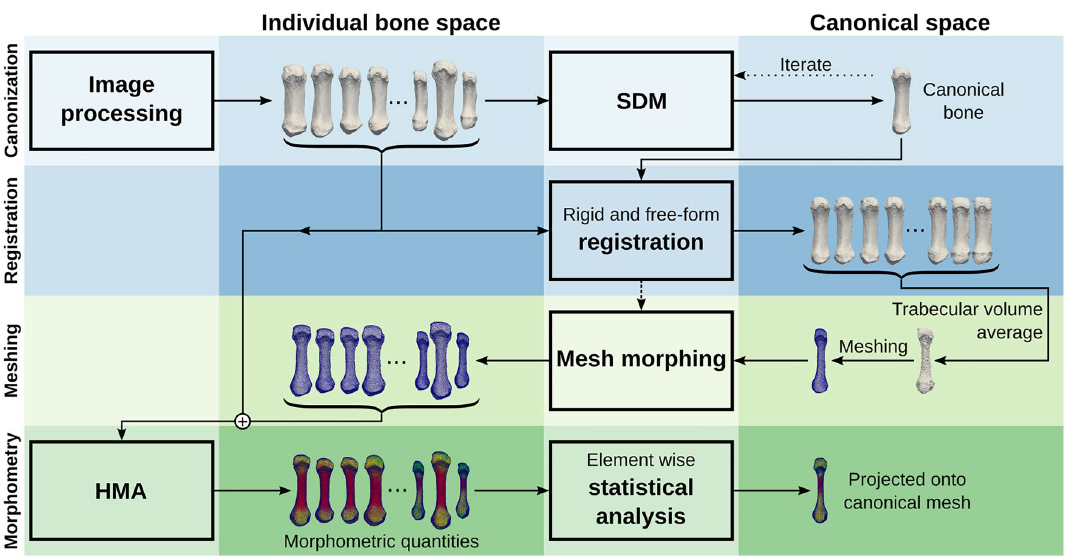
Figure 2. Graphical summary. Each block describes a separate step in the workflow, which runs from top to